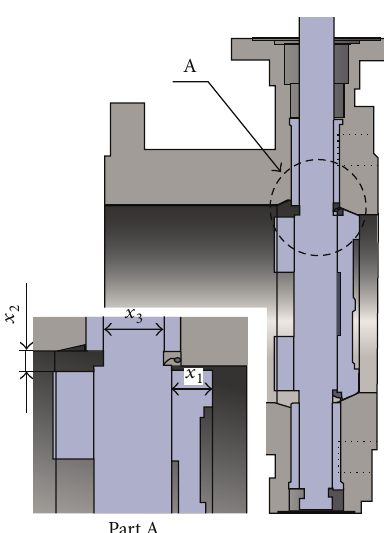
Figure 4: Design variables selected for the shape optimization of the valve